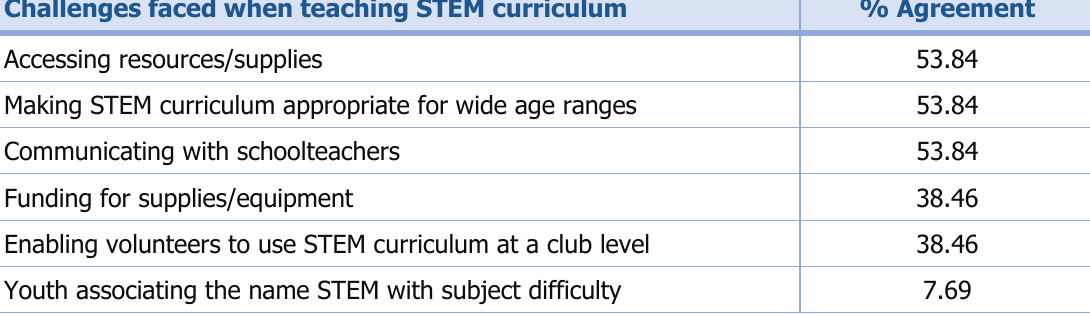
Table 4. Challenges Statements and Agreement Percentages in Round 2: Educator Panel (N = 13)